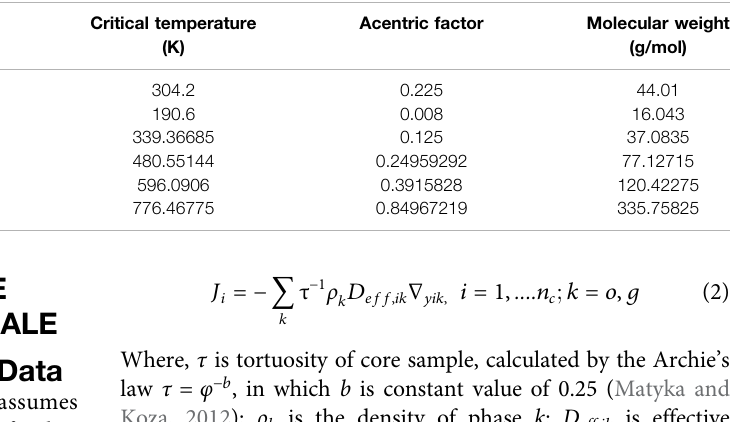
TABLE 5 | Composition and properties of live oil